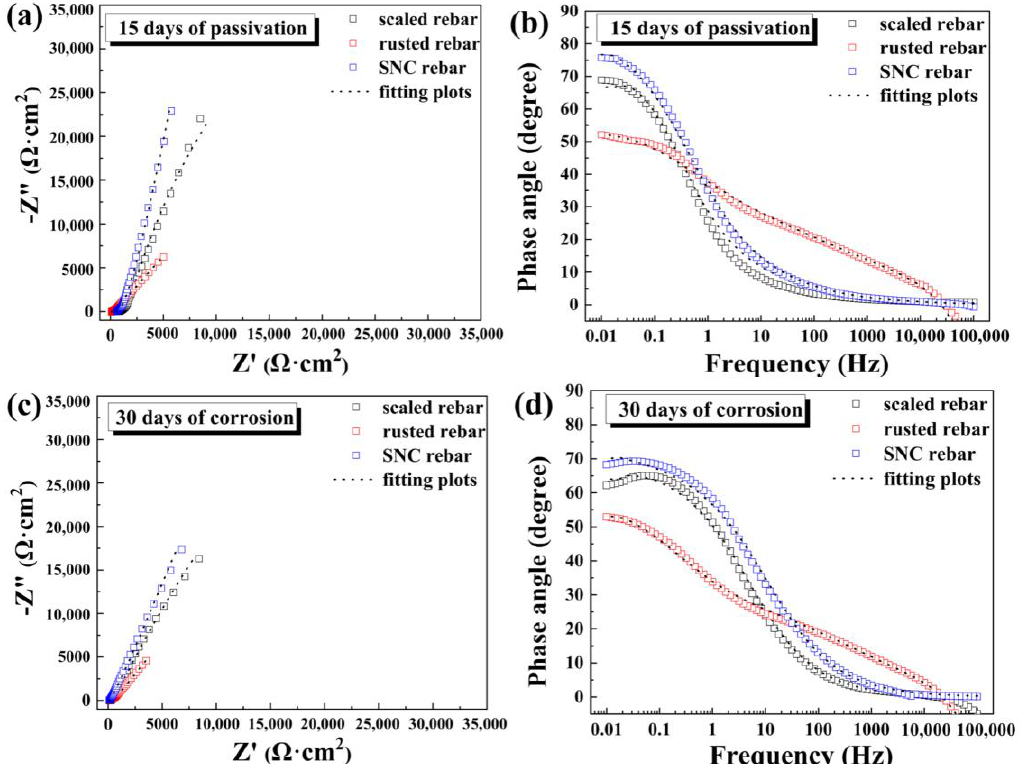
Figure 5. EIS plots of the rebar tested during passivation and corrosion in the SCPS: ( a , b ) Nyquist and Bode diagrams of passivation; ( c , d ) Nyquist and Bode diagrams of corrosion. A two-time constant circuit R s ( Q f R f )( Q dl R ct ) was applied to fit the EIS results of the scaled rebar and the SNC rebar. R s represents the solution resistance of the SCPS. R f